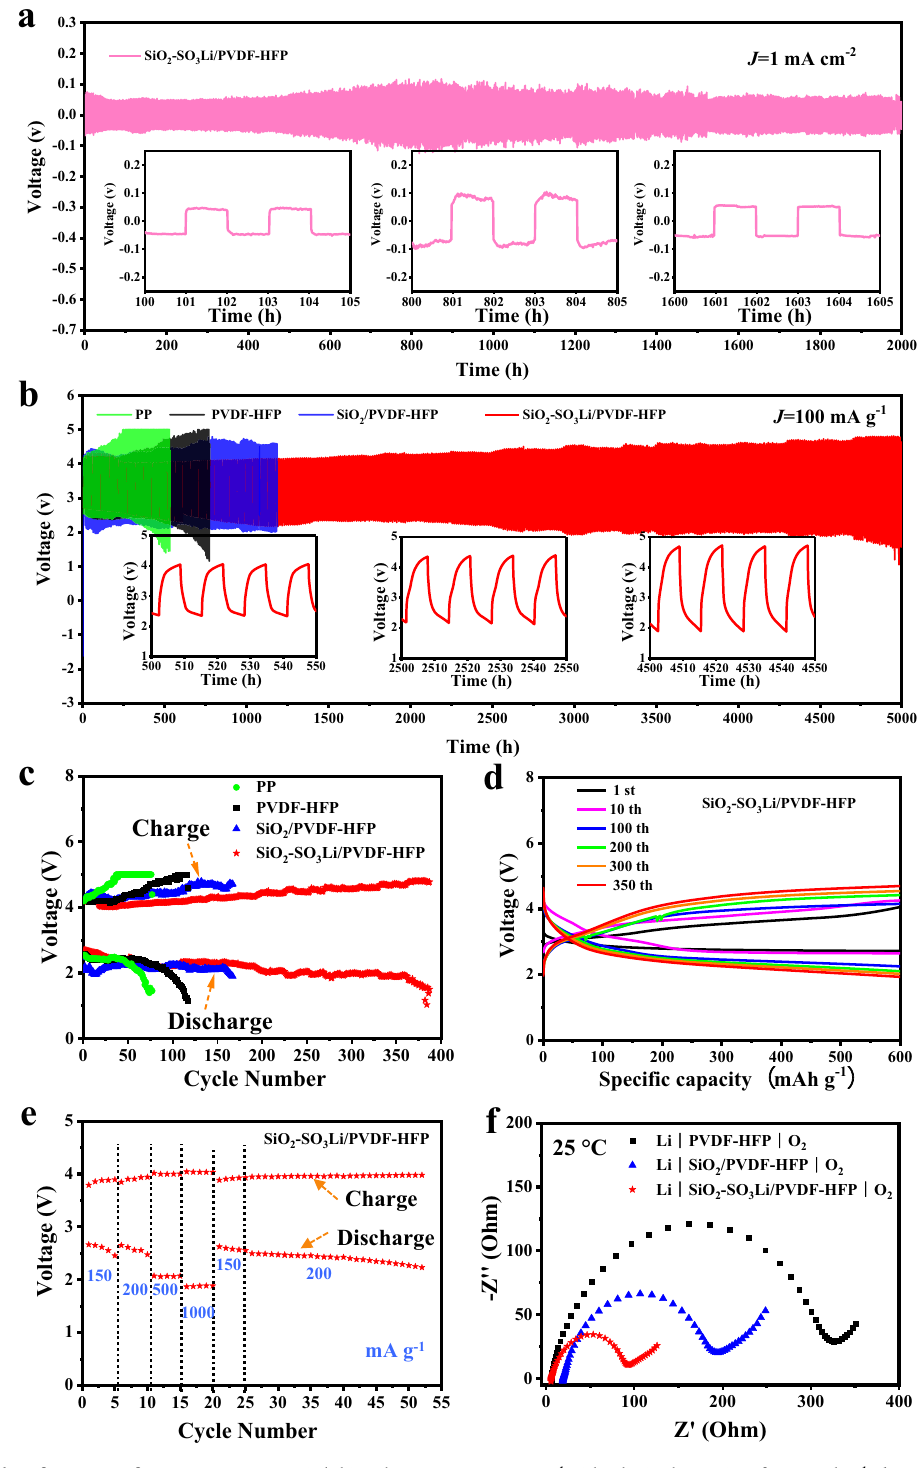
Fig. 4 | Electrochemical performance of NNFQSE. a Symmetric lithium battery basedonSiO 2 -SO 3 Li/PVDF-HFP testedat 1mAcm − 2 ,1mAhcm − 2 at25°C, the inserts are selected voltage pro fi les for a different time; b , c Cycling stability of Li-O 2 cells with three kinds of quasi-solid electrolytes and conventional separator (PP) at